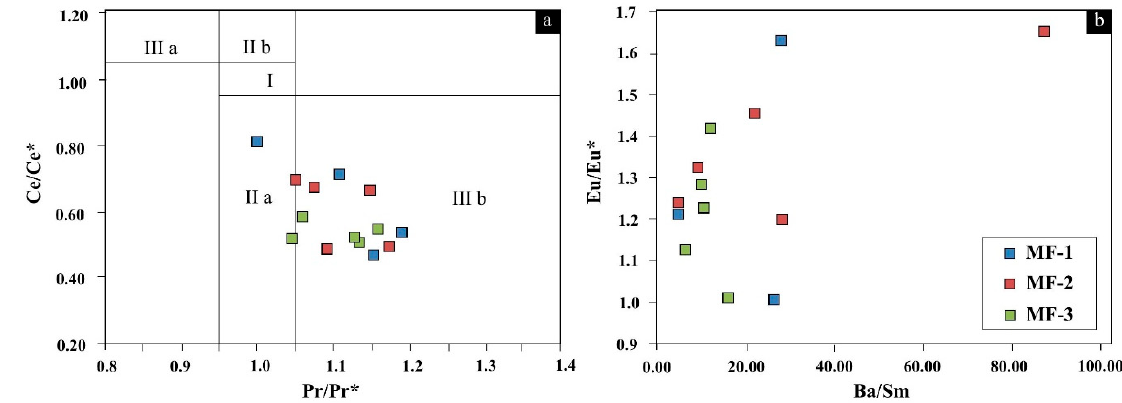
Figure 5. Plots of the Pr / Pr* vs. Ce / Ce* ratios diagram [69] ( a ), and Ba / Sm vs. Eu / Eu* ratios ( b ) of studied limestones. See the text for further details.